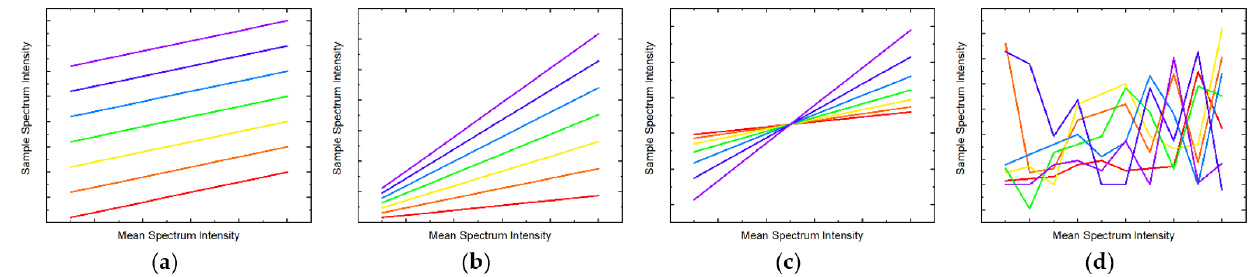
Figure 5. Exemplary scatter effects plots of ( a ) additive effects, ( b ) scatter effects, ( c ) additive and scatter effects, and ( d ) complex effects. Colors indicate spectra from different samples.